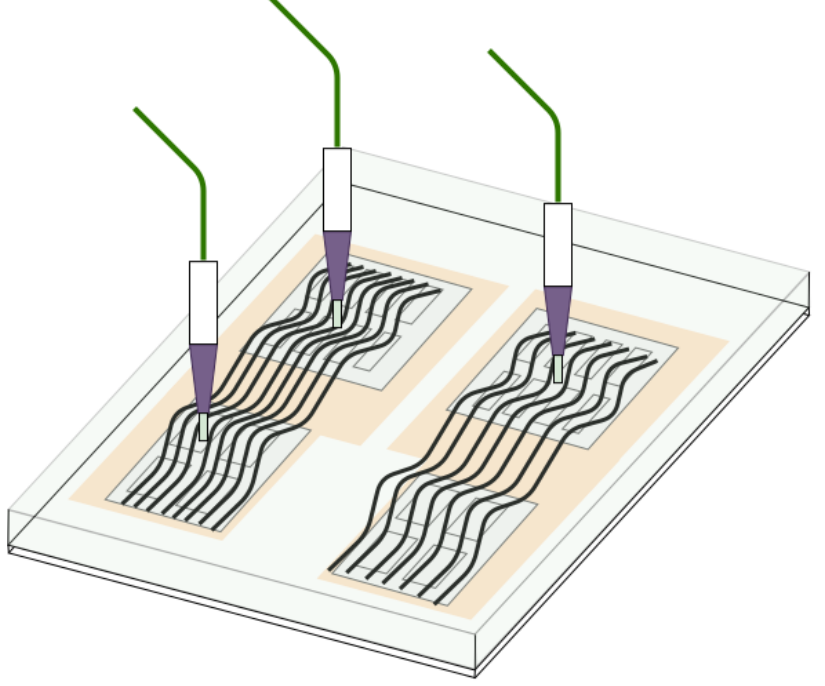
Figure 3. Example of a power module with optical fiber thermal sensors (Based on [49]).